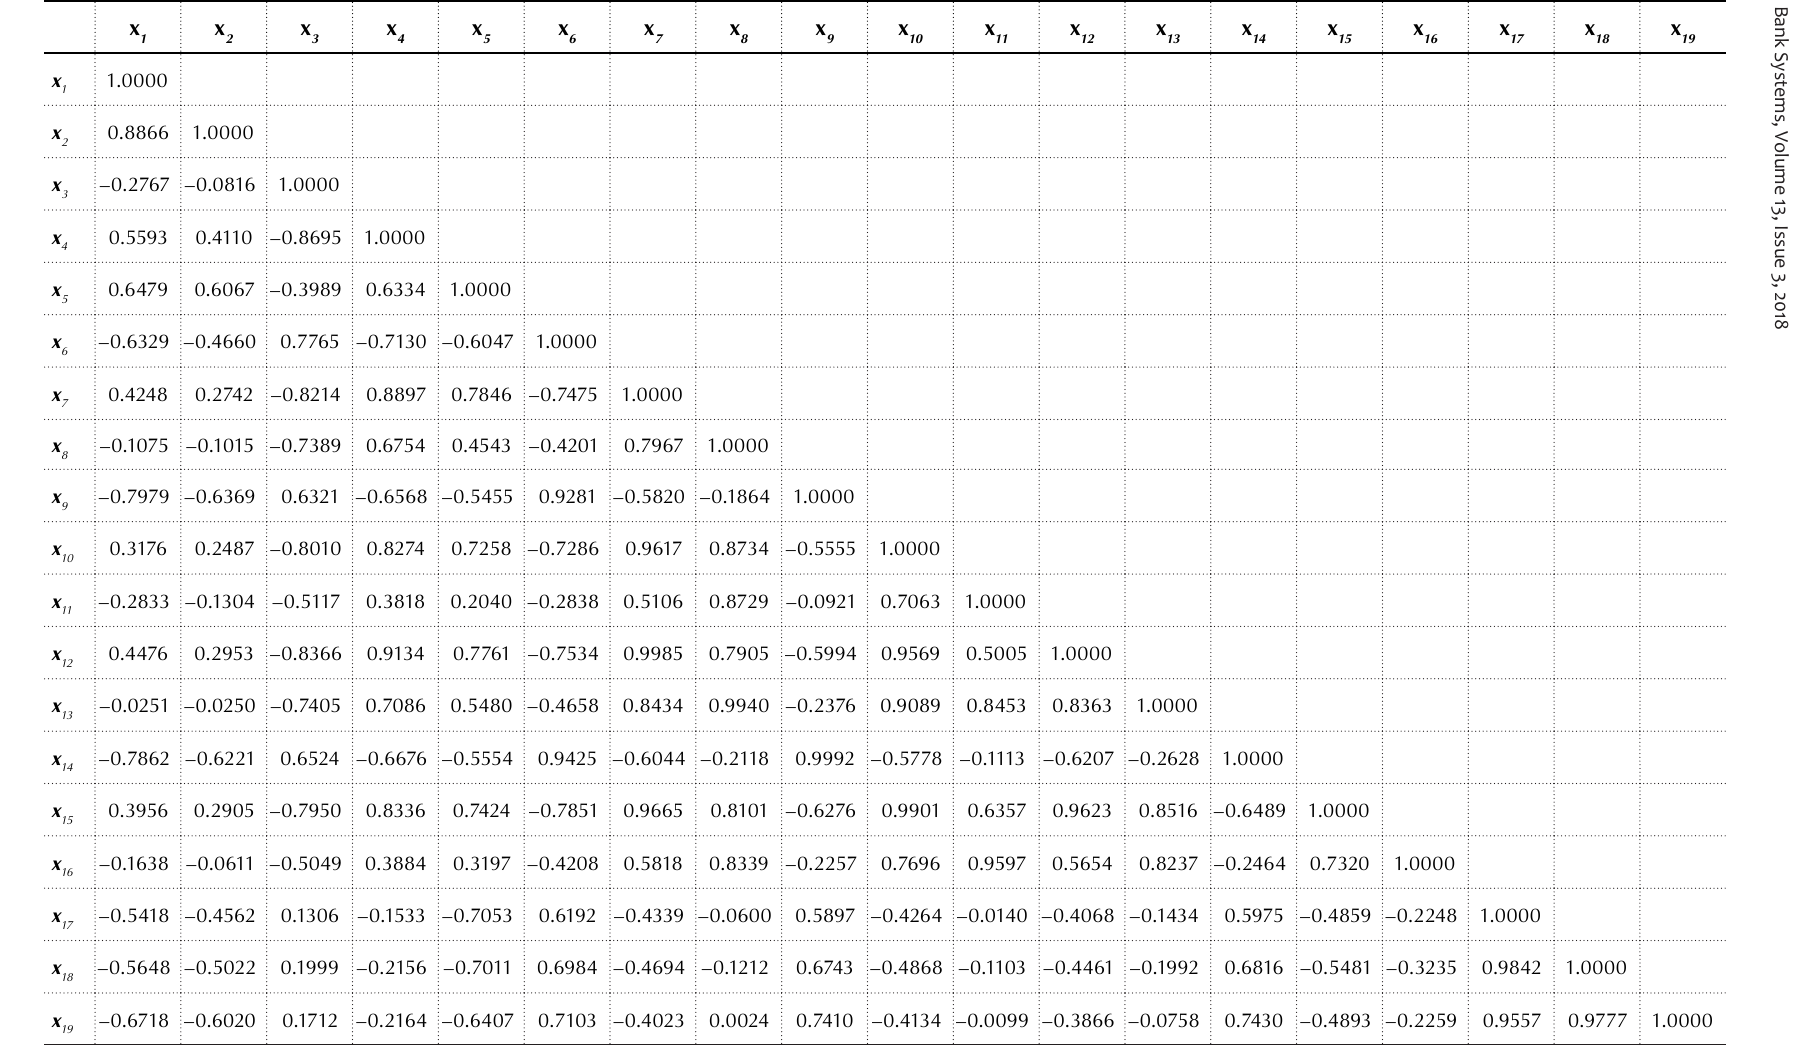
Table 3A. Matrix of pair correlations for factor indicators of the model